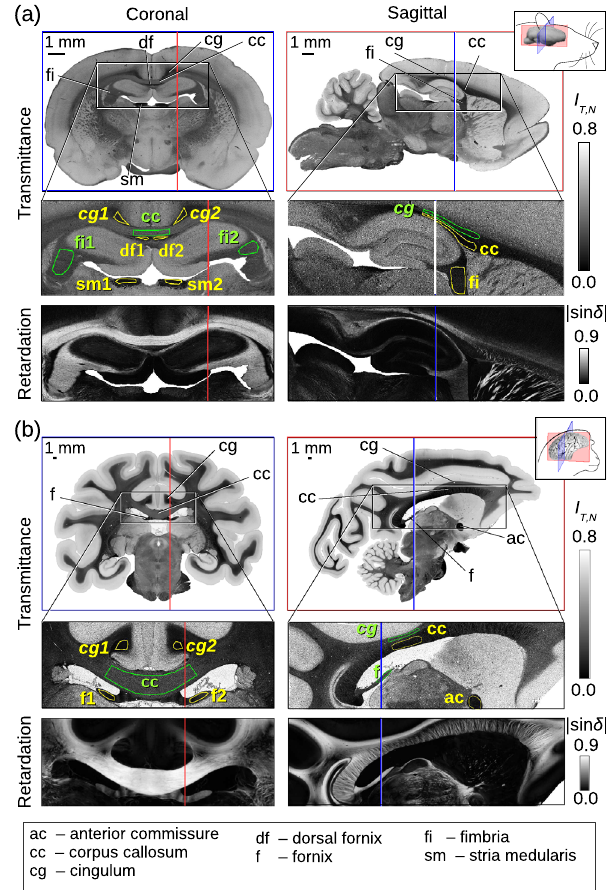
FIG. 11. Transmittance and retardation images of coronal and sagittal brain sections for a rat (a) and a vervet monkey (b). The coronal (sagittal) section planes are indicated by blue (red) lines in the respective other brain section for reference, and selected anatomical structures are labeled (see the legend). The upper two rows of each panel show the normalized transmittance images I , and the third row shows the retardation images j sin δ j , both T;N obtained from 3D-PLI measurements with 1 . 33 μ m pixel size. The images in the first row show the whole brain section, and the images in the second and third rows show an enlarged view. The selected regions in yellow (green) belong to steep (flat) nerve fibers, which appear dark (bright) in the transmittance and retardation